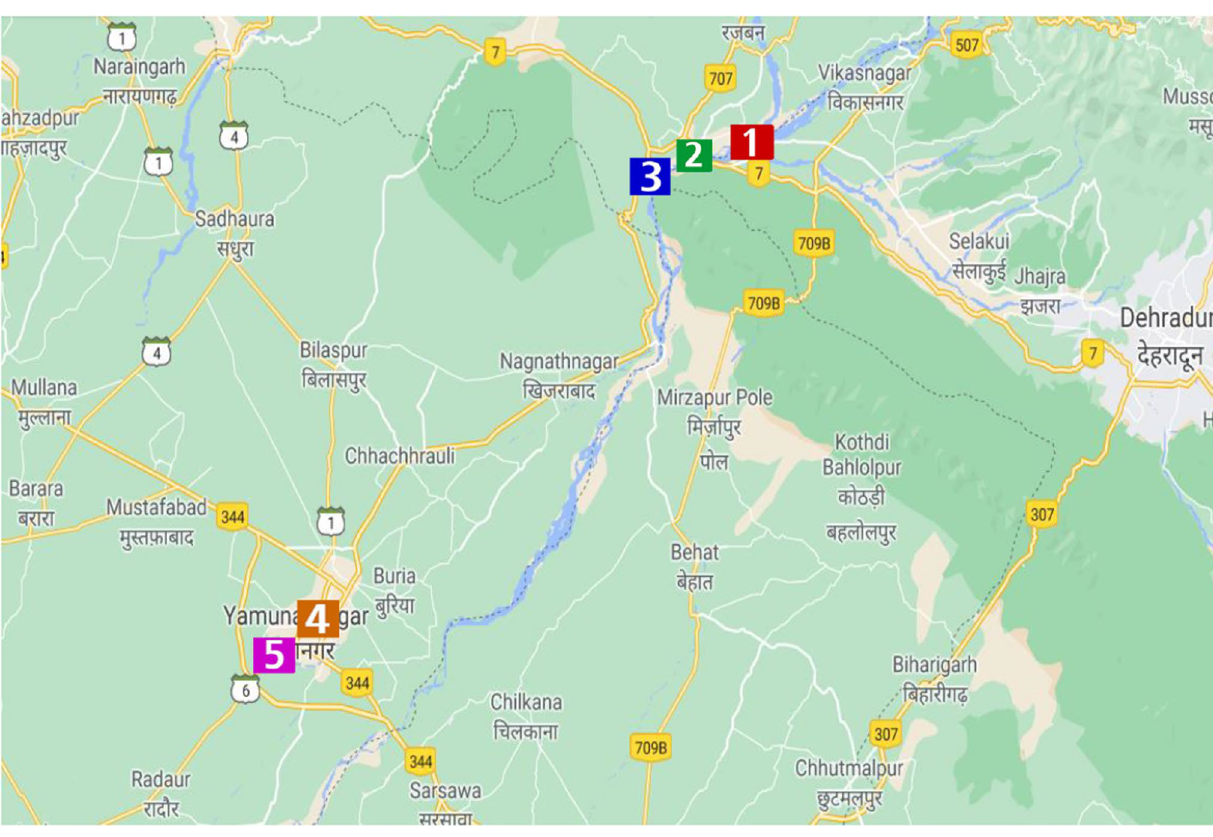
Fig. 1 Map of study area Table 2 Various Index levels and their corresponding water quality Water qual- ity